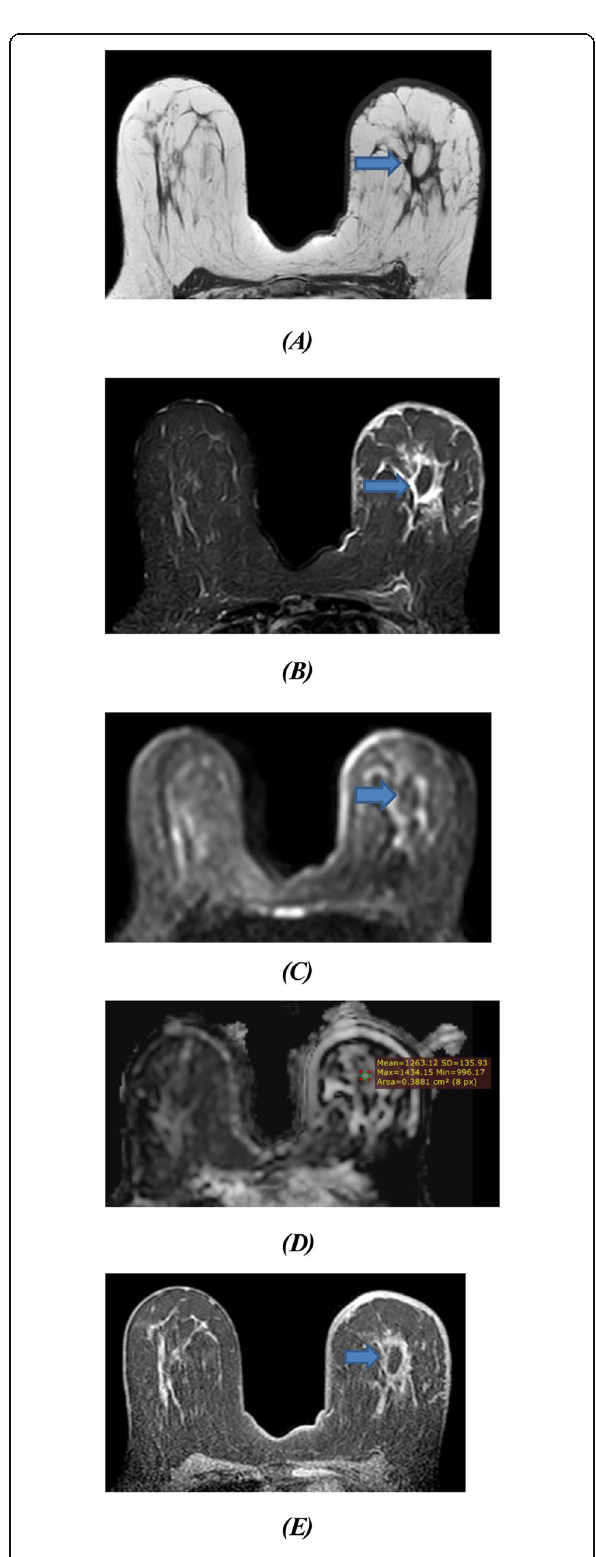
Fig. 2 Female patient aged 38 years with history of left breast cancer underwent conservative breast and then presented by palpable lump. a Axial T1WI showed lesion of high signal intensity in the left breast. b Axial STIR image, the lesion appeared of low signal intensity. c , d DWI and ADC map, the lesion appeared free on diffusion with a mean ADC value = 1.29 × 10 – 3 mm 2 /s. e Dynamic MR image showed marginally enhanced oval shaped lesion in the left breast. Pathological diagnosis revealed fat